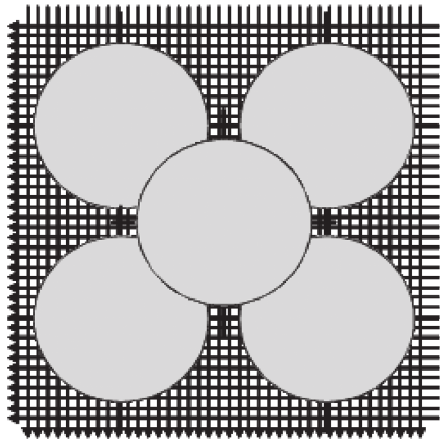
Figure 3: Test point